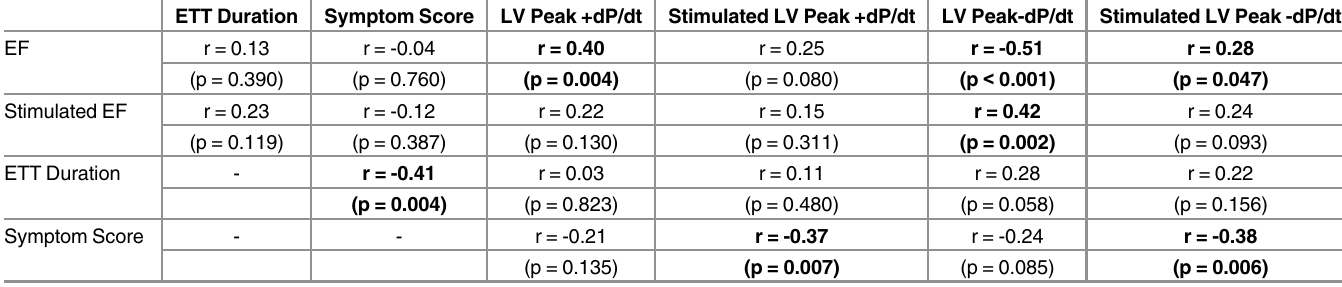
Table 3. Correlations Among Markers of LV